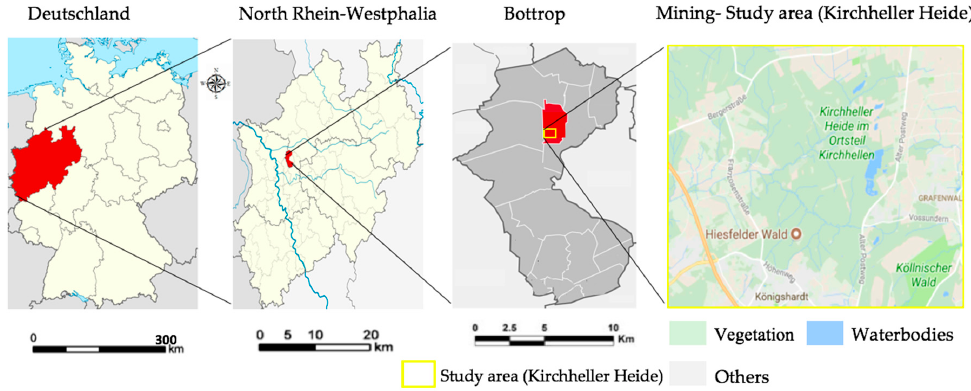
Figure 2. Location of Kirchheller Heide and mining area. The maps were created using Google